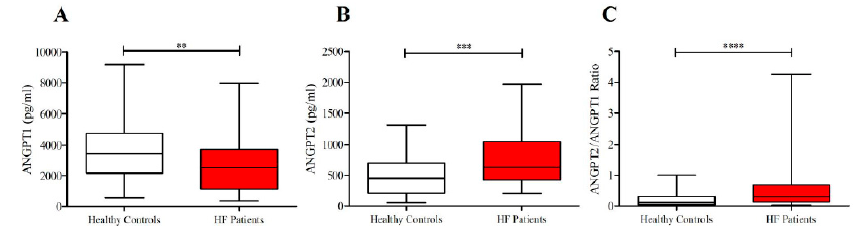
Figure 1. ( A ) Plasma concentrations of angiopoietin-1 (ANGPT1) in heart failure (HF) patients and in healthy controls; ( B ) Plasma concentrations of ANGPT2 in HF patients and in healthy controls; ( C ) ANGPT2/ANGPT1 ratio in HF patients and in healthy controls. Data are shown as the median (horizontal block line), the 25th and 75th percentiles (boxes), and the 5th and 95th percentiles (whiskers) (statistical analysis was performed by a Student’s t -test). ** p < 0.01; *** p < 0.001; **** p < 0.0001.